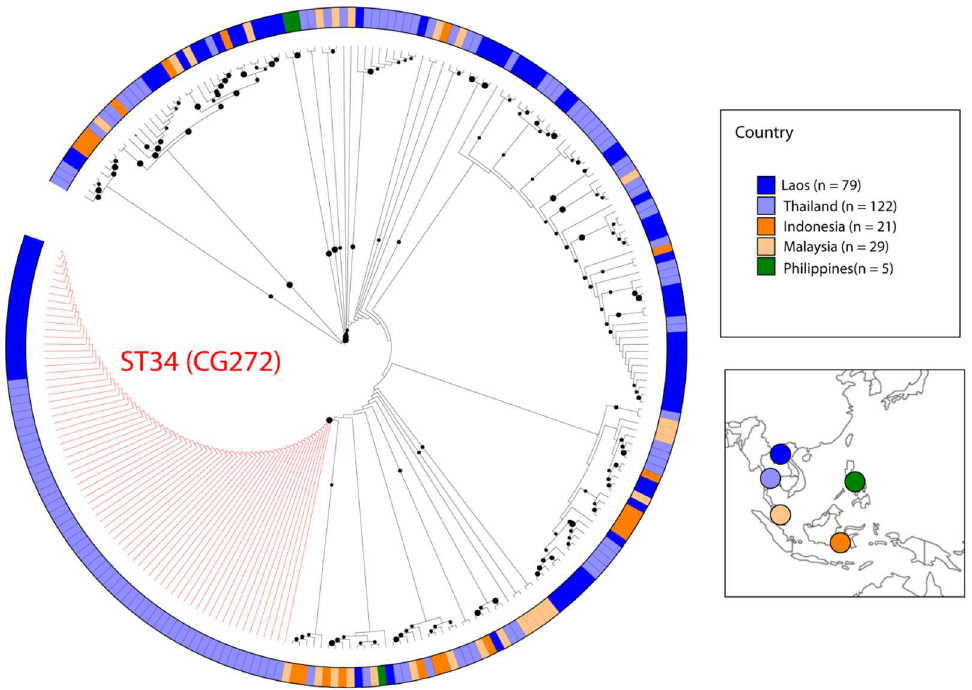
Fig 2. Prevalence of the ST34-like strains in Laos and neighbouring countries. Phylogenetic relatedness of pathogenic Leptospira strains (n = 258) circulating in Southeast Asia. Maximum-likelihood phylogeny based on 994 SNVs found in 3,113 bp-long concatenated sequences of glm U, pnt A, suc A, tpi A, pfk B, mre A and cai B loci characterized by MLST1 [30] together with the samples analyzed in this study. Isolates belonging to the ST34 (CG272) are highlighted in red. Metadata associated with the isolates not listed in S1 Table are provided in S2 Table. The base layer of the map is from outline-